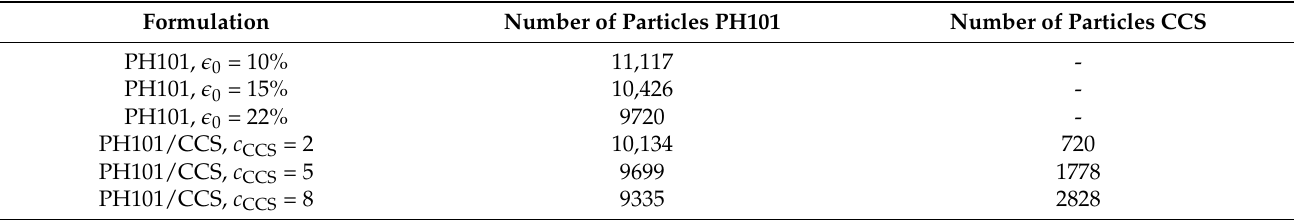
Table 4. The number of particles simulated for each